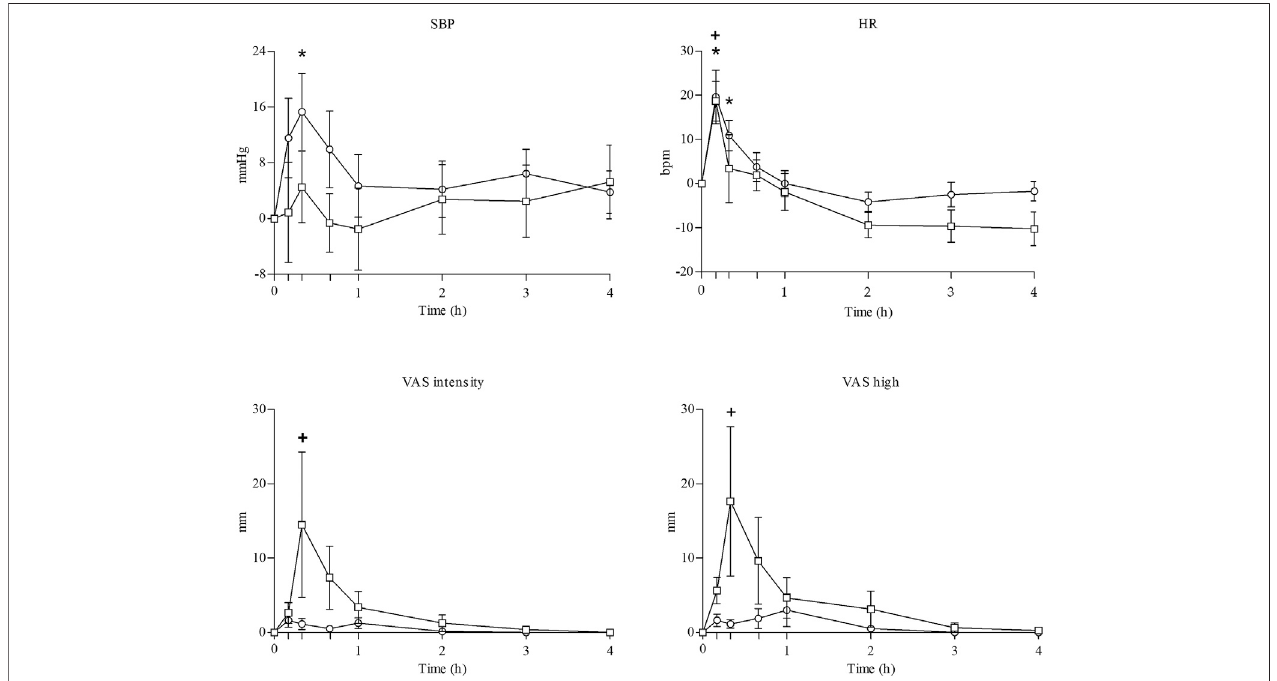
FIGURE 1 | Summary of the course of main physiological (systolic blood pressure and heart rate) and subjective effects (intensity and high in visual analog scales) observed after administration of JWH-122 ( n (cid:1) 8) and JWH-210 ( n (cid:1) 8). ○ JWH-122; □ JWH-210; values are mean and standard error. Symbols indicate a signi fi cant difference to baseline: for JWH-122 * ( p < 0.05); for JWH-210 + ( p < 0.05), + ( p < 0.05).